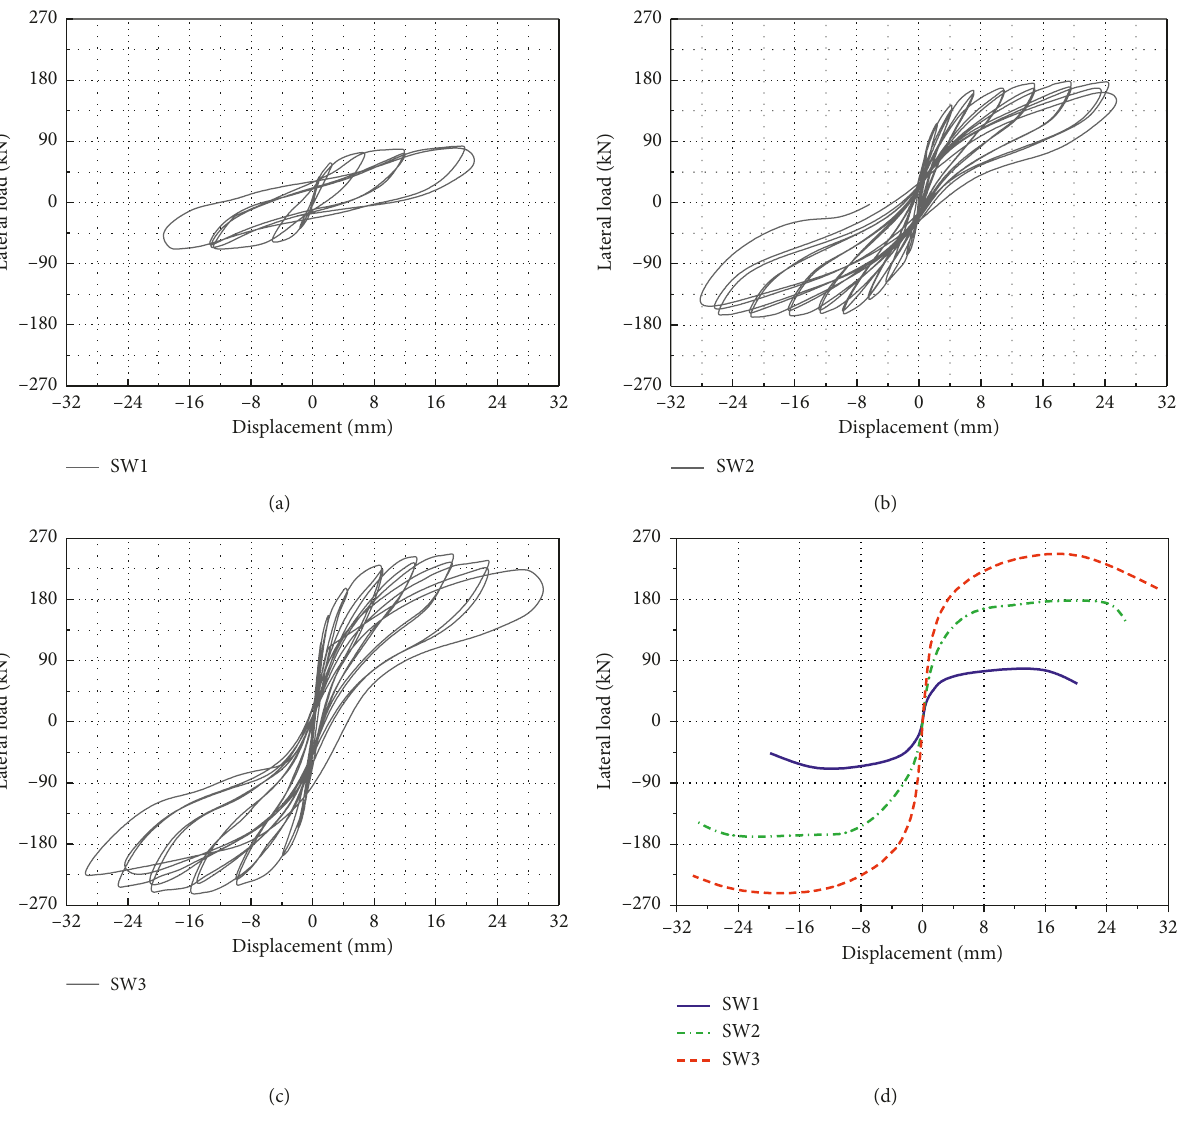
Figure 15: Hysteretic curves and backbone curves of the test specimens: (a) SW1, (b) SW2, (c) SW3, and (d) backbone